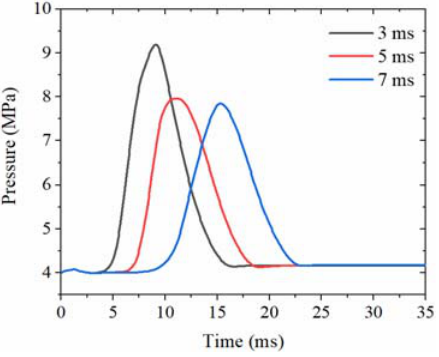
Figure 4. Pressure traces of prechamber for different spark timings.